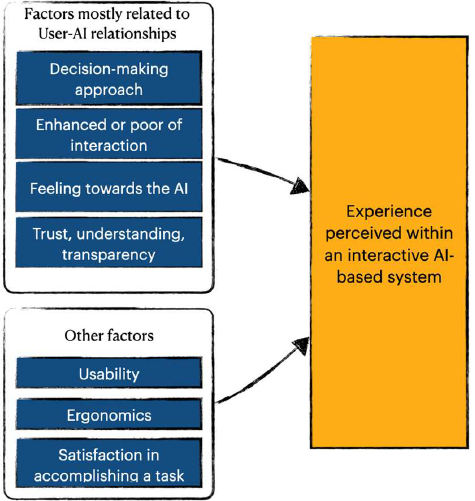
Figure 1. Factors influencing the UX in an AI-based system. Elaborated from [10].